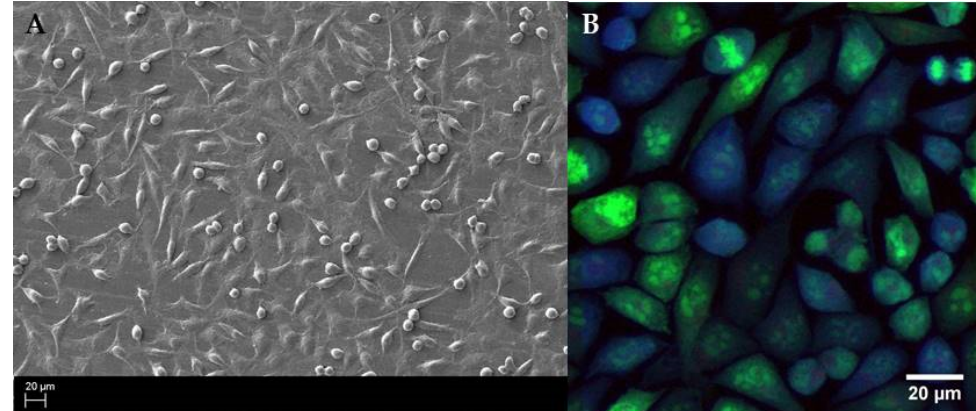
Figure 3. Image of a dense monolayer of fibroblast cells, after 16 h of culture imaged by ( A ) electron scanning microscopy, magnification 500 × . And ( B ) confocal microscopy using CellTrace Violet ® and Syto 9 ® (magnification 40 × , scale bar 20 µ m). It should be noted that the SEM picture allowed to confirm cofluence of fibroblasts and their proper (elon- gated) morphological shape, while confocal microscopy, coupled with the application of specific dyes, confirmed the fibroblasts’